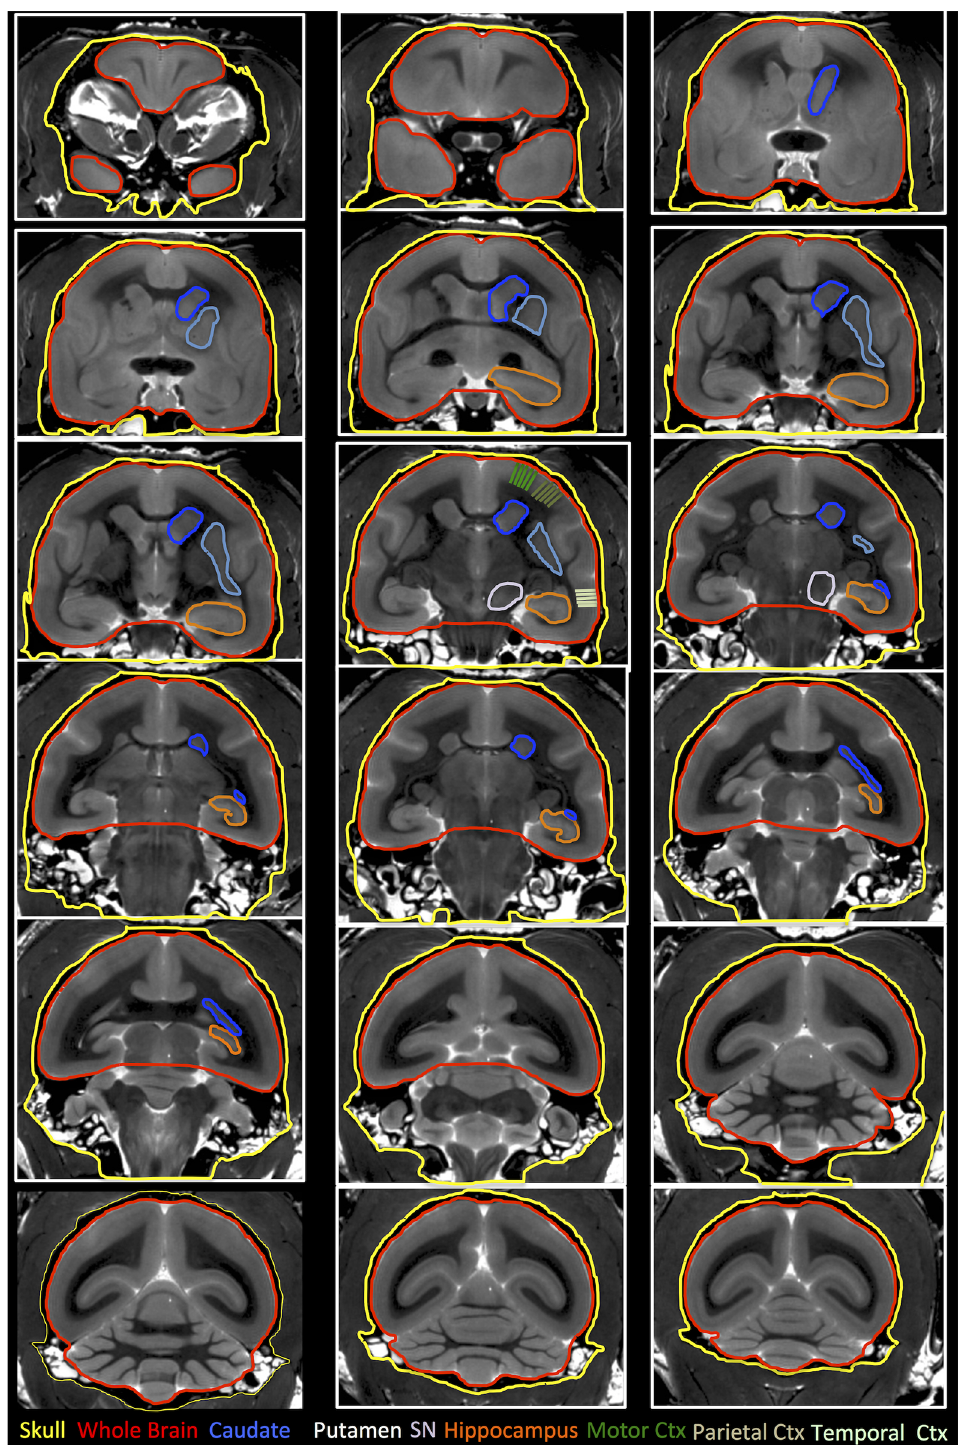
Fig 2. Definition and delineation of regions of interests on T 2 -weighted MRI scans. To control for overall age and growth differences betweenanimals, total skull volume was measured, as this is considered an independentmeasurement that is not affected by changesin brain tissue and allows a contrast with total brain volume. Using the marmoset atlas [49], the caudate, the putamen, the substantianigra (SN), and hippocampus were delineated.Cortical thickness was evaluatedin the motor, parietal and temporalcortex (Ctx) using five